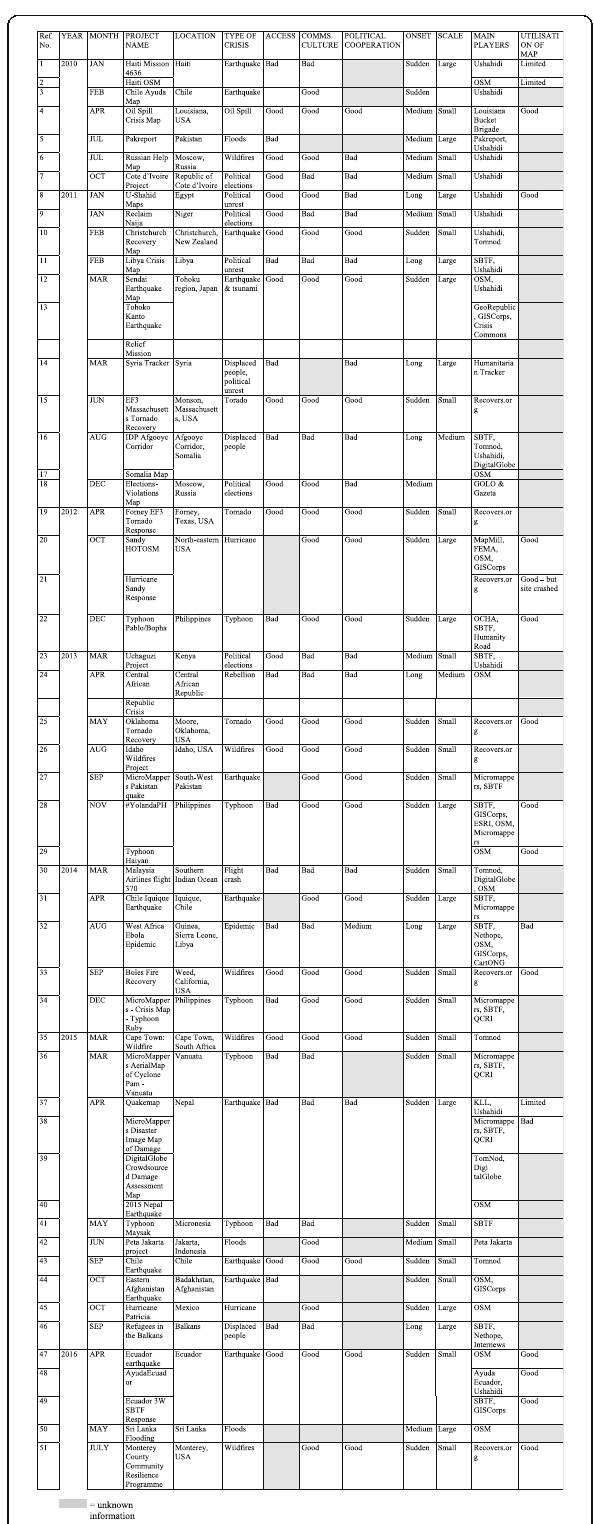
Fig. 1 Crisis contexts of crowdsourced mapping based on Kuryak (Interview 2016), Link (Interview 2016), Meier (Interview 2016) and Moore (Interview